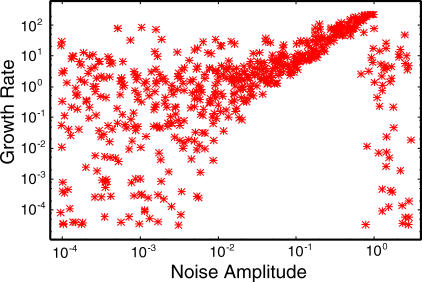
The Relationship between the Noise Amplitude σ and the Growth Rate vg
Starting from randomly chosen initial conditions against the noise amplitude σ ranging 10−4 < σ <3, the growth rates vg after 105 time steps are plotted. In the intermediate range σ of the noise strength 10−2 < σ <1, cellular states with high growth rates are selected among a huge number of possible cellular states, as depicted in Figure 2.